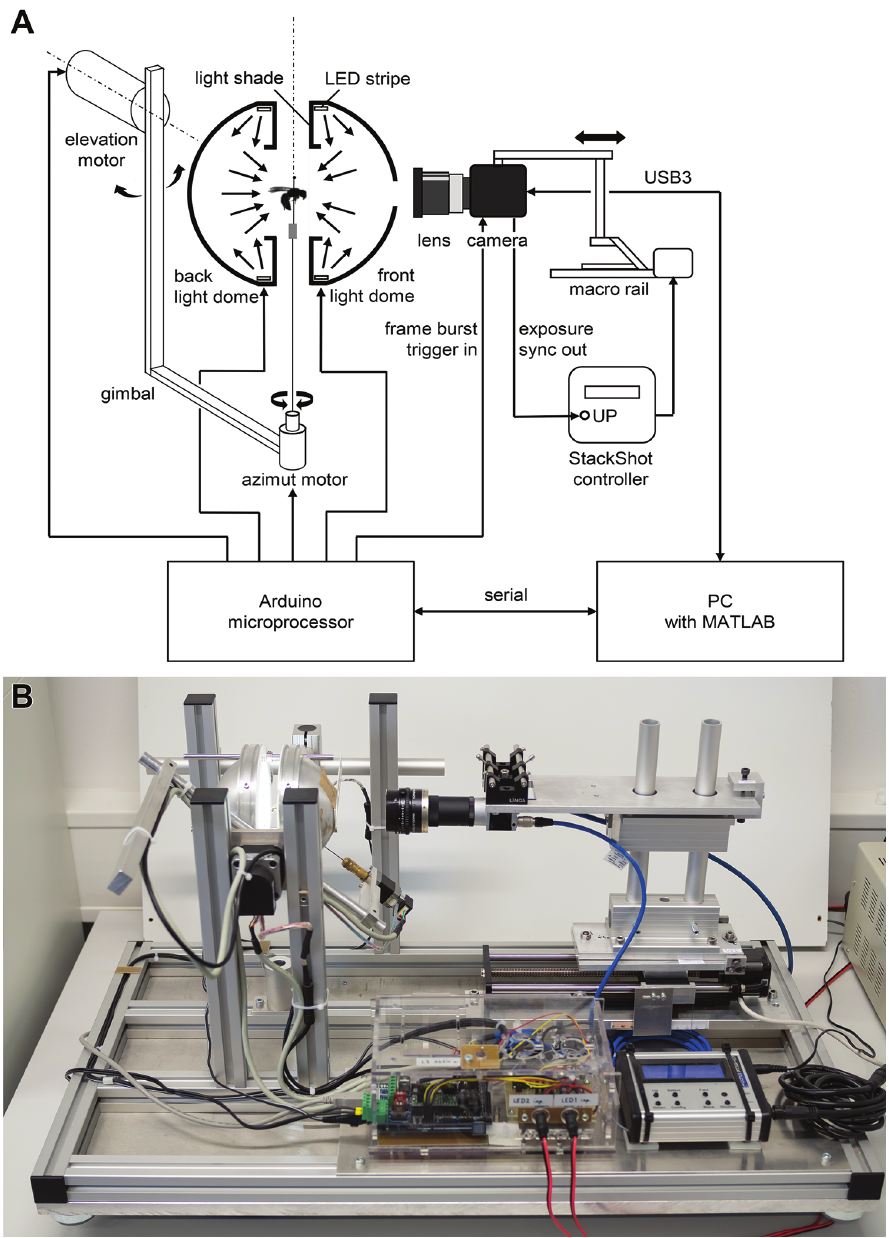
Figure 1. Schematic setup ( A ) and image ( B ) of the Darmstadt Insect Scanner DISC3D. DISC3D (Fig. 1) and the measuring process. Detailed technical information and calculations can be found in the supplement. Visit also www.econetlab.net/disc3d for current